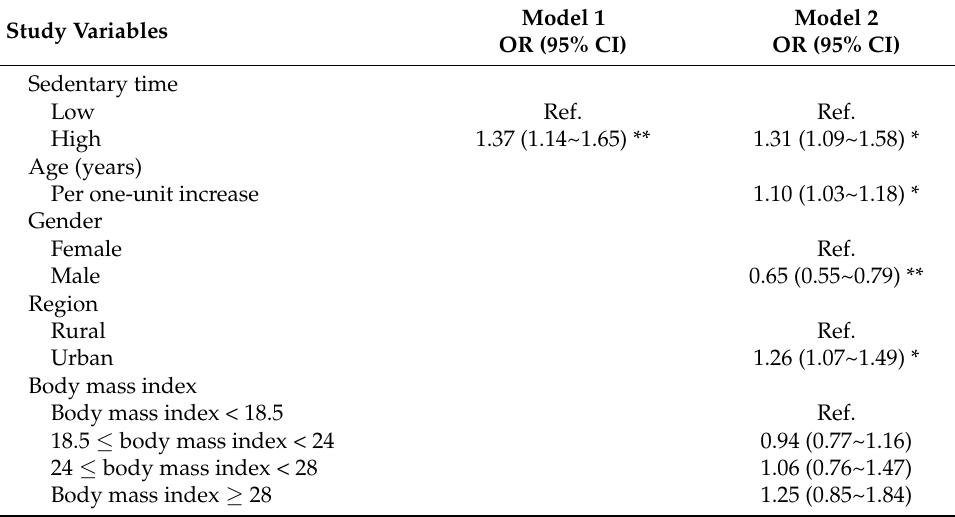
Table 3. Associations between sedentary time and poor sleep quality among Chinese college students.